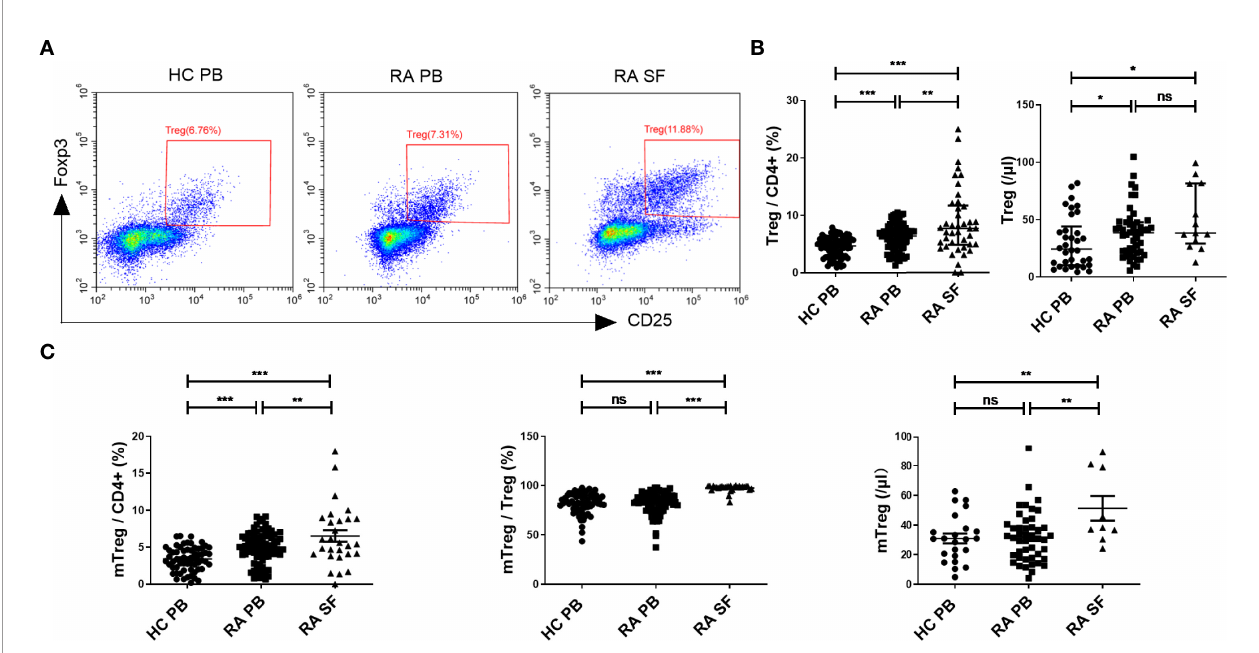
FIGURE 1 | The comparation of Treg cell levels among HC PB, RA PB, and RA SF. (A) Flow cytometric dot-plots of Treg cells in HC PB, RA PB, and RA SF. (B) Cumulative data of Treg cells in HC PB, RA PB, and RA SF. (C) Cumulative data of mTreg cells in HC PB, RA PB, and RA SF. Data are from 86 RA patients, 76